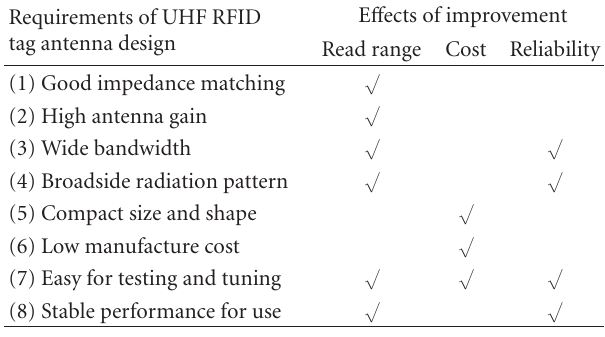
Table 1: Requirements for designing a UHF RFID tag antenna.